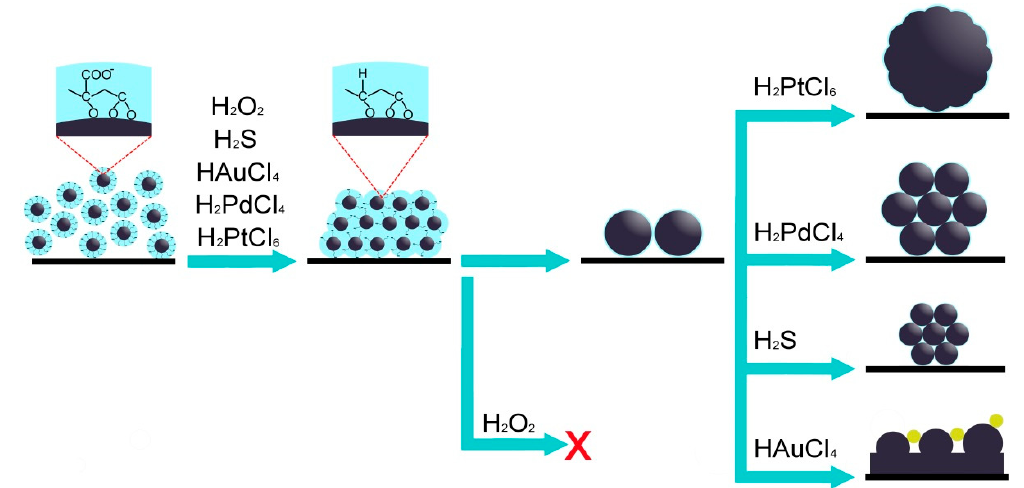
Figure 9. Scheme illustrating likely mechanisms of Ag NPs enlargement and sintering.